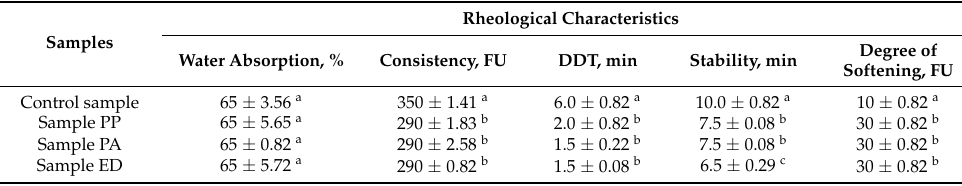
Table 3. Effect of sourdoughs on the rheological characteristics of nongluten